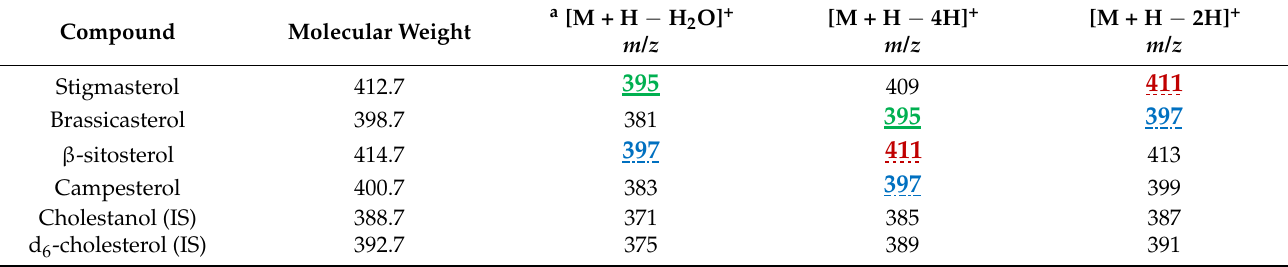
Table 1. Observed analyte-to-analyte interferences amongst phytosterols due to the presence of other minor ions. Compound Molecular Weight